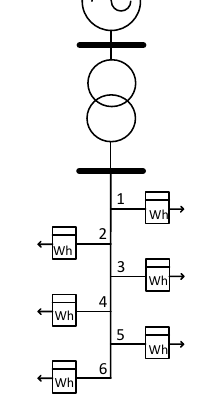
Figure 2. Power system circuit